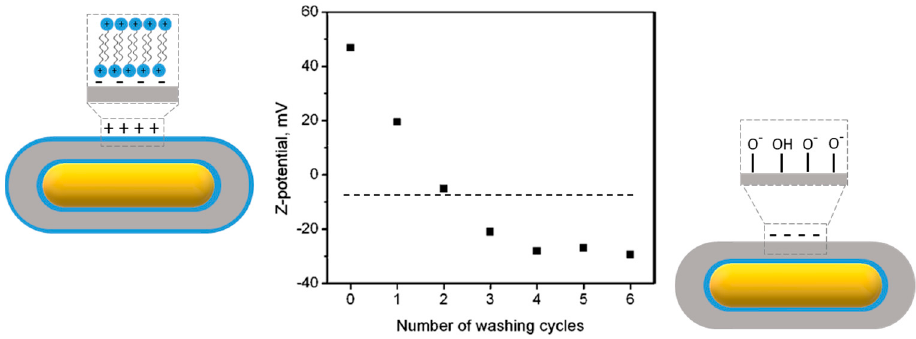
Figure 15. Monitoring CTAB removal by zeta potential measurements, adapted from [78].